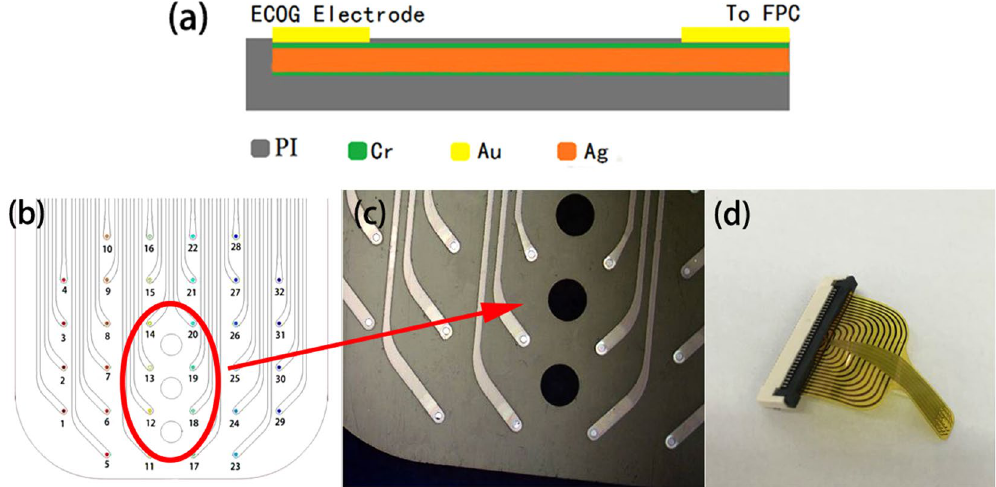
Figure 3. Flexible microelectrodes array. ( a ) Cross sectional view of a microelectrode, ( b ) ECoG electrode device with 32 microelectrodes, ( c ) a microscope image of the microelectrodes and three large holes for drug injection, and ( d ) a photo of the ECoG electrode device, clearly showing its